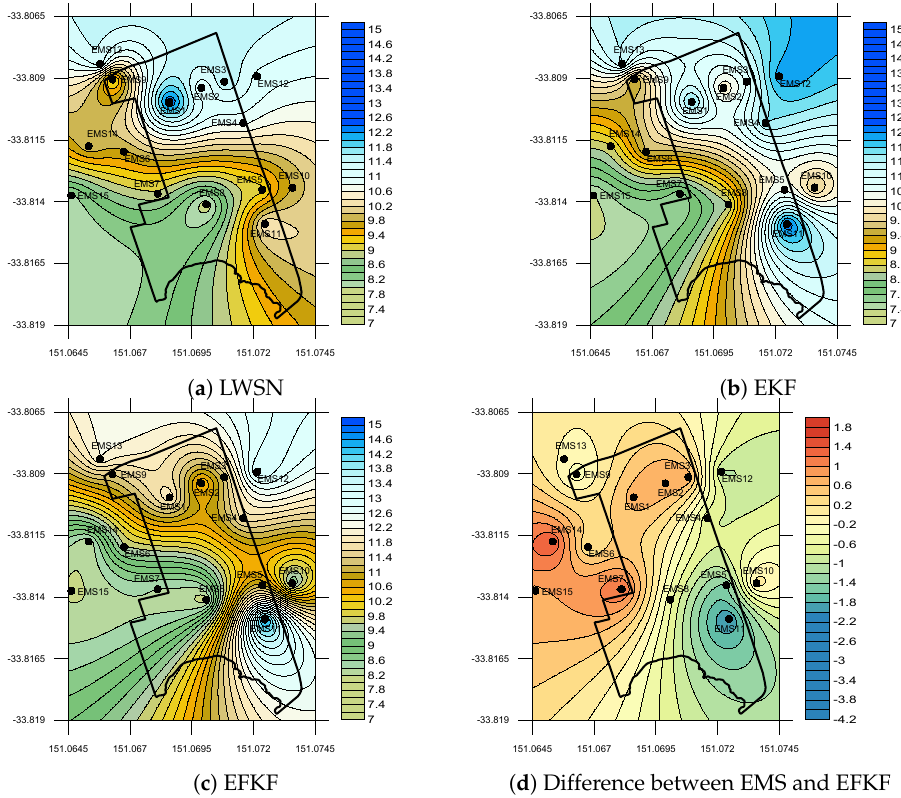
Figure 10. Local PM1 ( µ g/m 3 ) concentration on 3 APR 2020 at 7:00